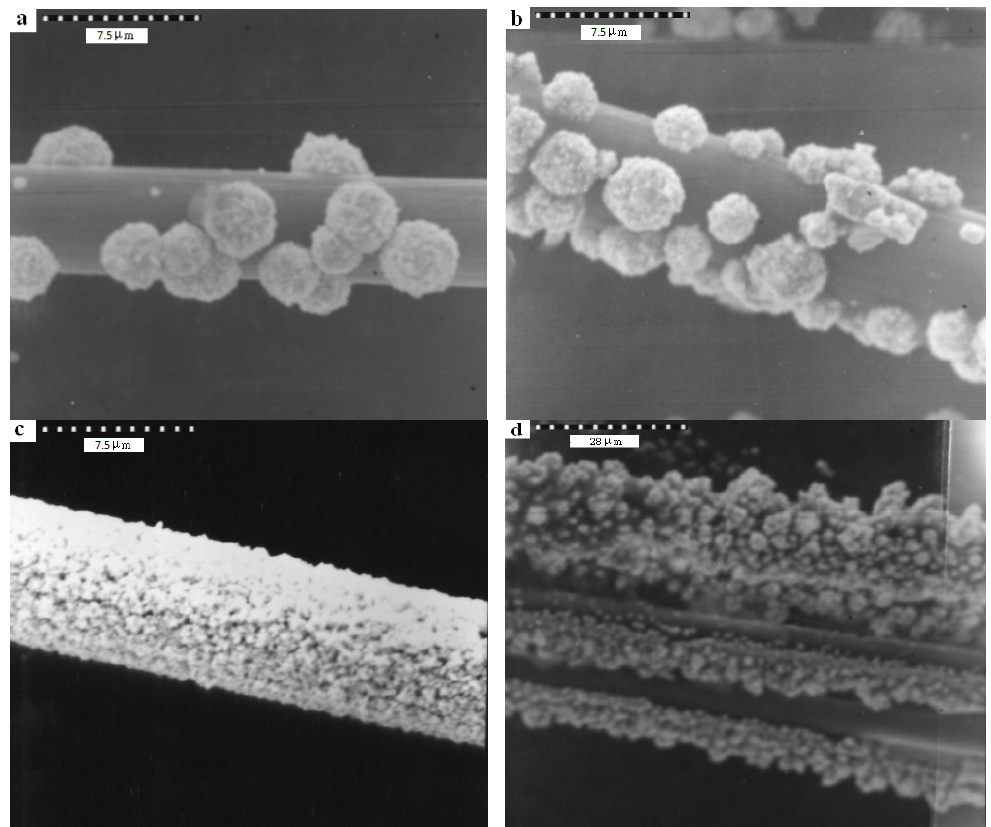
Figure 9. Scanning electron micrographs (at 4 kV) of a Au-coated carbon fiber composite surface. ( a ) Au (4 mM) deposits 240 s; ( b ) Au (4 mM) deposits 360 s; ( c ) Au (4 mM) deposits 480 s; ( d ) Au (4 mM) deposits 540 s in 0.1 M acetate buffer (pH 5.02).